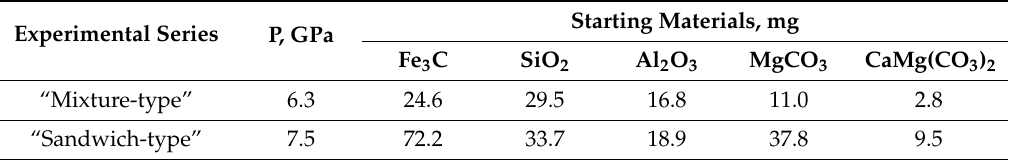
Table 1. Mass proportions of starting materials.